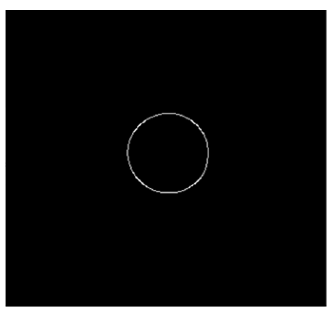
Figure 11. Image after binarization.